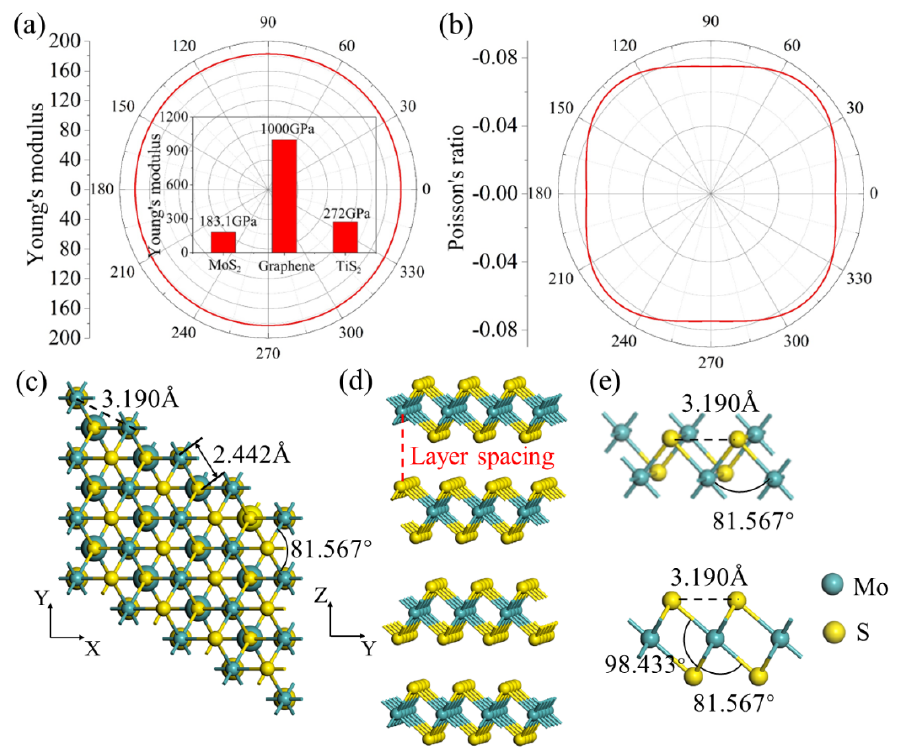
Figure 1. ( a ) Young’s modulus and ( b ) PR of MoS 2 as a function of the angle θ . θ = 0° corresponds to the X -axis. The comparative Young’s modulus of the three materials is plotted in the Young’s modulus diagram of MoS 2 . ( c ) Top view of bulk MoS 2 (space group R3m). The partially enlarged atoms in the figure are the obscured parts of the layered MoS 2 , and the red dashed lines indicate the spacing between the layers. ( d ) Side view of MoS 2 . ( e ) Local enlargement of the side view of the monolayer MoS 2 .